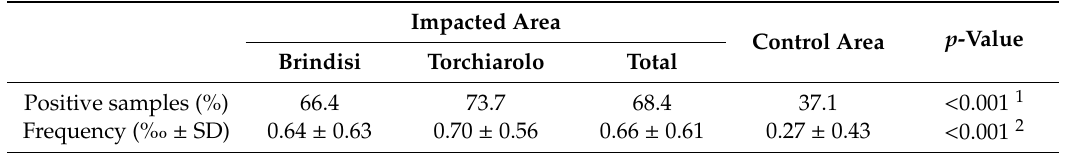
Table 6. Micronuclei (MN) positive samples (%) and frequency (% (cid:24) ± SD) in EBC (exfoliated buccal cells) of children living in the two